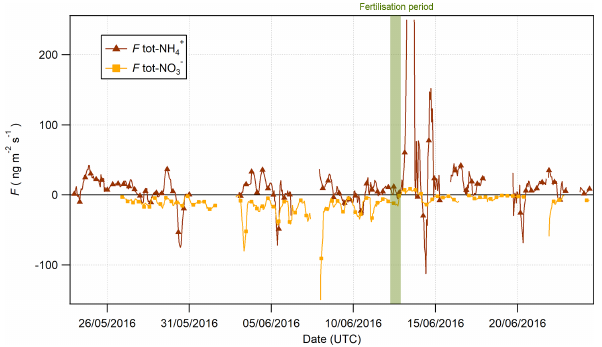
Figure 13. Fluxes of tot-NO − tion on 13 June 2016 at 09:00 (marked in